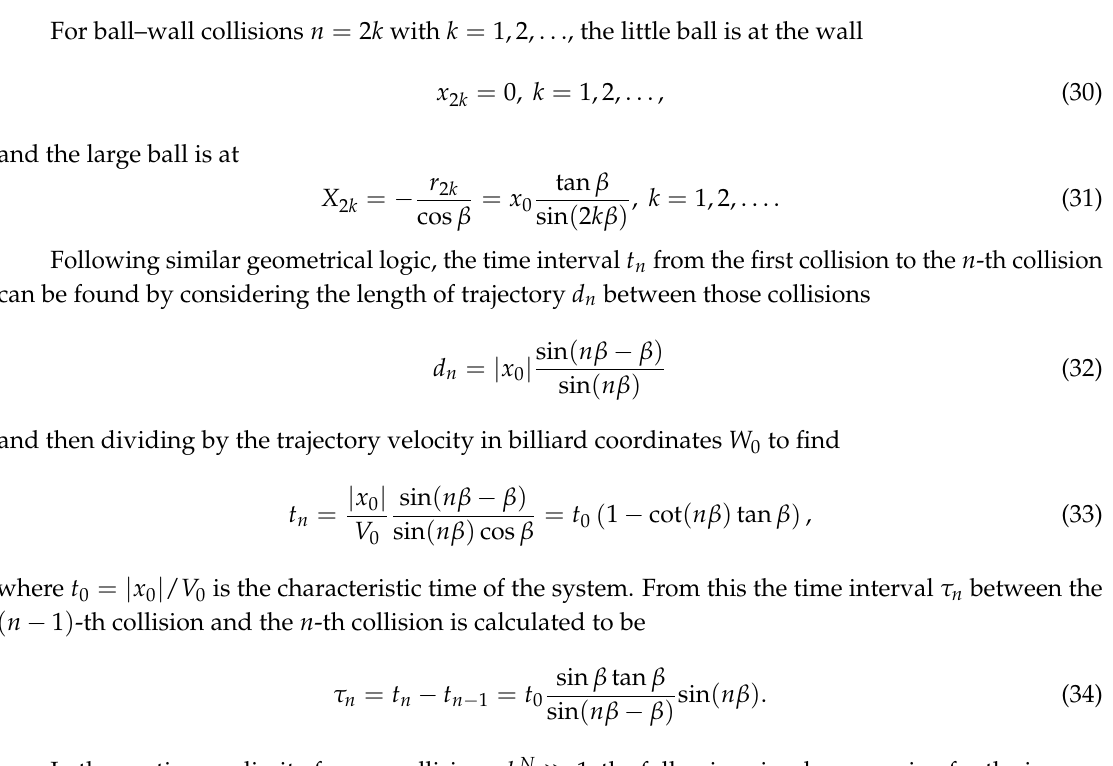
Figure 8. Unfolded trajectory depicting relations among trajectory and billiard coordinates. The brown line is the trajectory specified by the initial conditions with L 2 = mMx 2 For this mass ratio M / m = 7.5, there are eight collisions, depicted as four disks for points with analysis and four circles for other points. Odd-numbered ball–ball collisions occur where the trajectory intersects red lines and even-numbered ball–wall collisions occur at blue lines. The angle for the n -th collision point is n β and the distance to the origin is r n . The projection of the ball–ball collisions onto the blue ball–wall lines are depicted by dashed